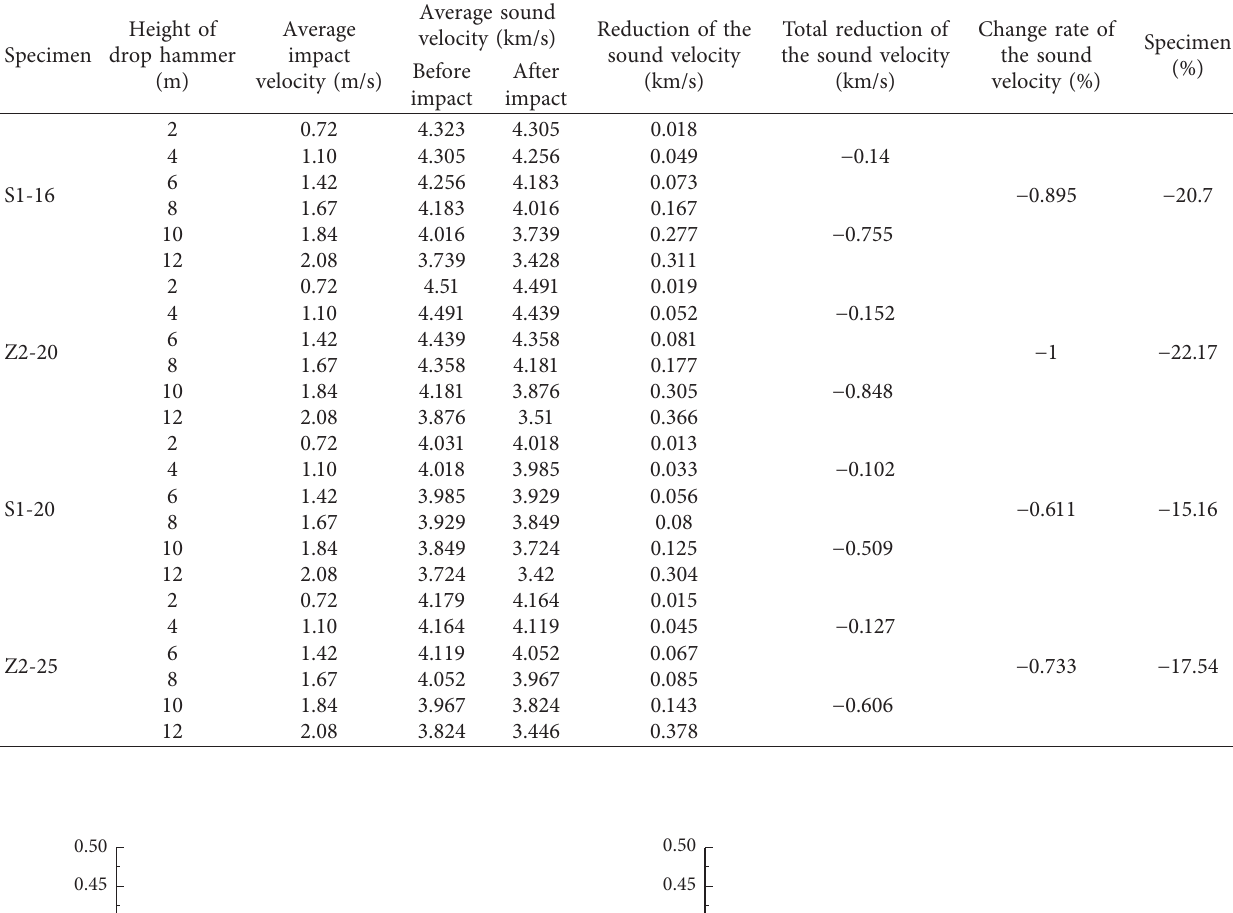
Table 10: Change of ultrasonic velocity of